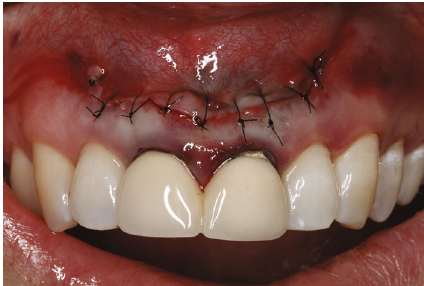
Figure 17: Flap suture with a non-reabsorbable 4/0 multi fi lament suture.